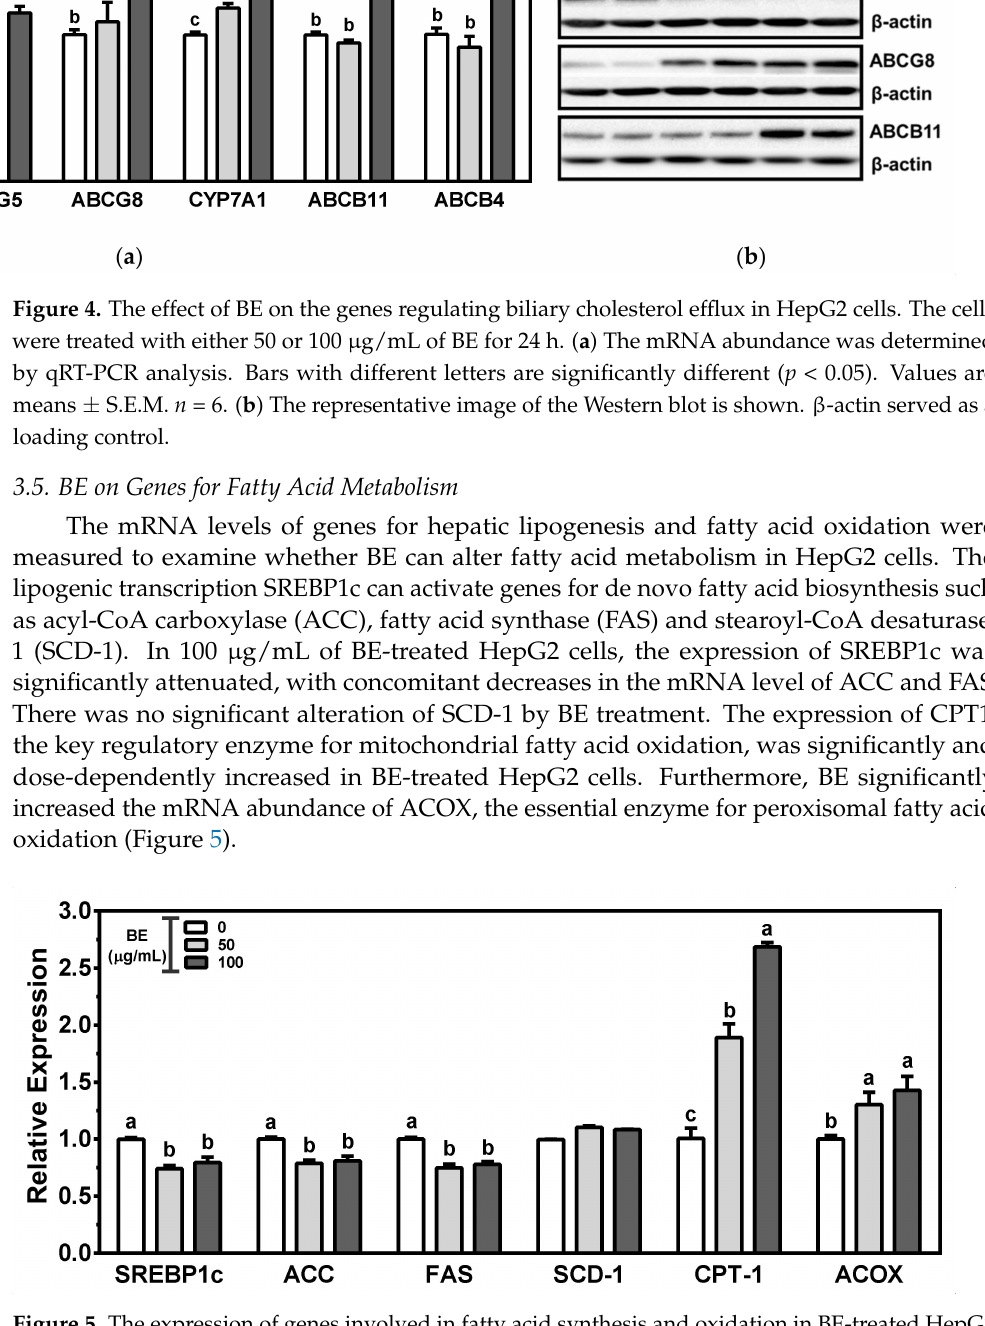
Figure 5. The expression of genes involved in fatty acid synthesis and oxidation in BE-treated HepG2 cells. Cells were treated with either 50 or 100 µ g/mL of BE for 24 h. The mRNA abundance was determined by qRT-PCR analysis. Bars with different letters are significantly different ( p < 0.05). Values are means ± S.E.M. n =